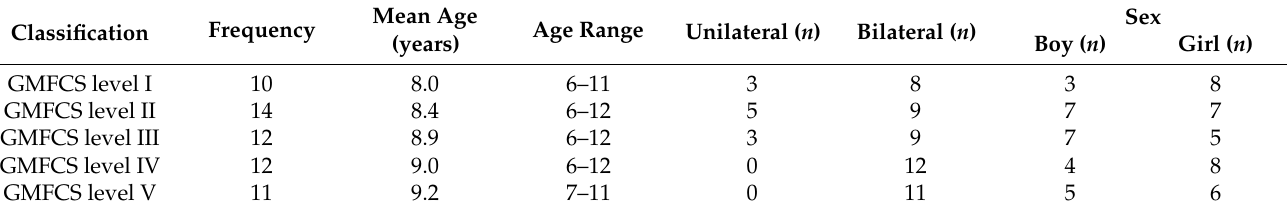
Table 1. General characteristics of the study participants ( n = 60).